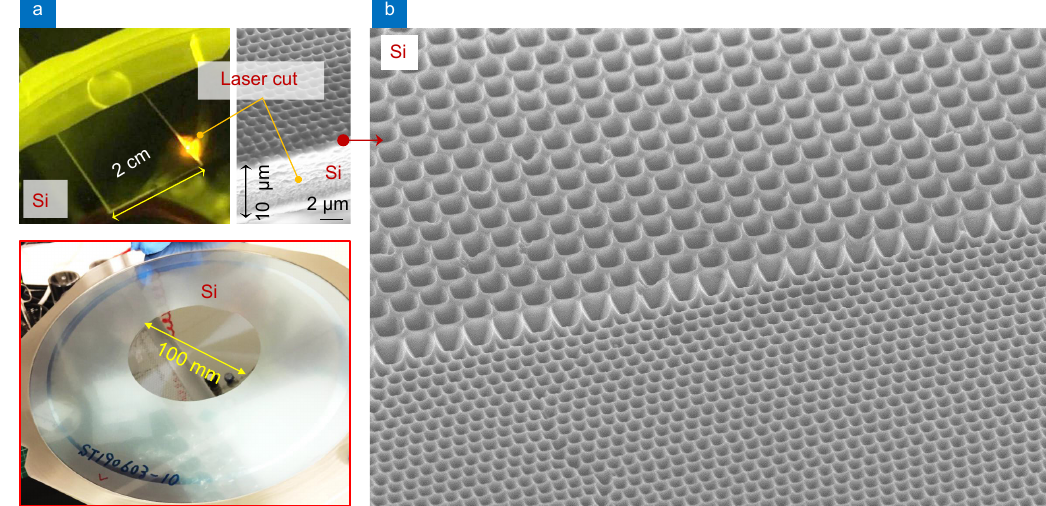
Fig. 4 | ( a ) 10-μm-thick Si wafer cut by E p ≈ 0.8 μJ energy fs-laser pulses (1030 nm/230 fs/200 kHz) using NA = 0.14 objective lens at 1 cm/s scan speed (5 passes with focus on the surface). SEM image of the 10-μm-thick Si wafer after cutting and patterning. Optical image of the 100- mm-diameter Si wafer on a plastic film. ( b ) PhC surface etched through holes ablated by fs-laser to define the Cr etch mask; NA = 0.9 lens was used, write speed 10 cm/s, pulse energy 12 nJ, laser repetition rate 200 kHz. Note the step height between regions with different period Λ . This step change is due to the under etch which is also responsible for formation of the upward-pyramid shown in inset of Fig.